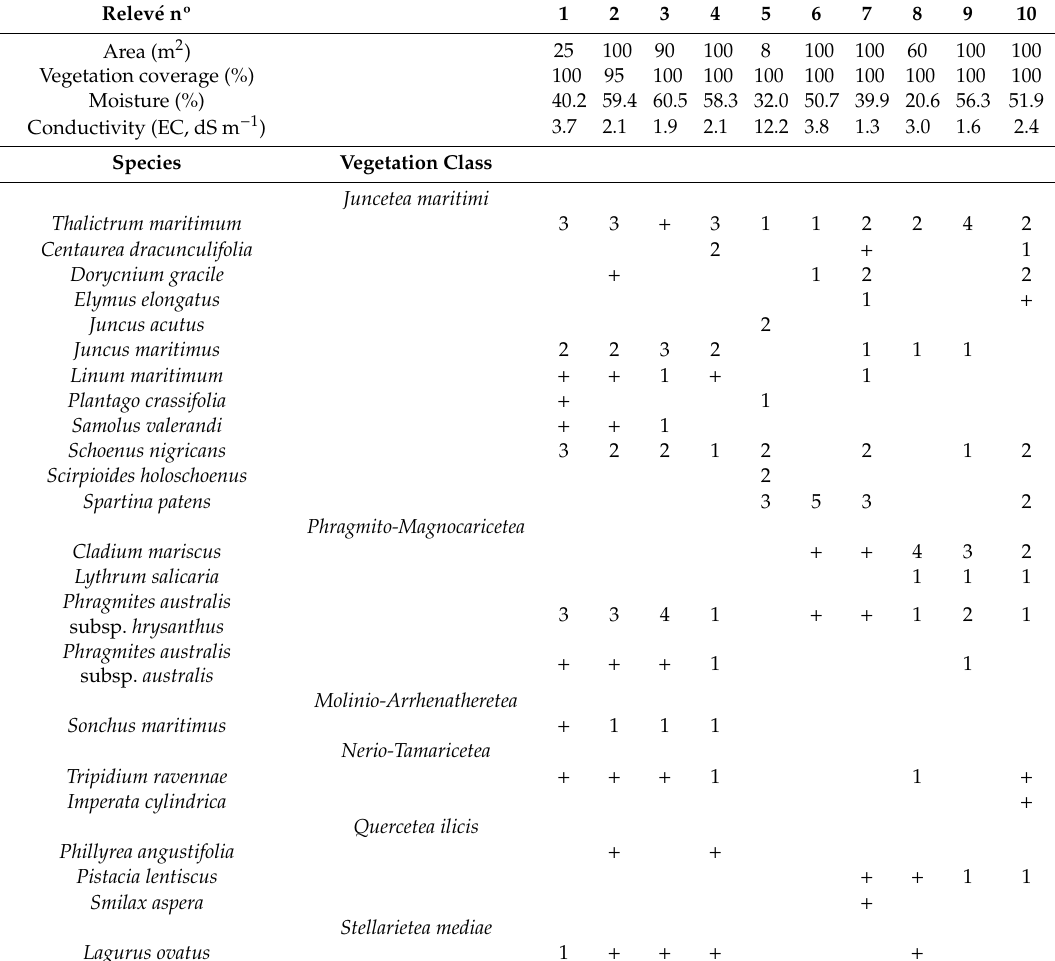
Table 1. Phytosociological relev é s with Thalictrum maritimum from the Natural Park of Albufera. The extension and vegetation coverage, as well as soil properties (moisture and electric conductivity) are shown for each of the ten relev é s. Ranges of cover of the species present in each relev é are indicated, according to the Braun-Blanquet’s cover-abundance scale [20]: occasional presence, < 5% ( + ); 5–12% ( 1 ); 12–25% ( 2 ); 25–50% ( 3 ); 50–75% ( 4 ); 75–100% ( 5 ). The species are classified into their corresponding vegetation classes